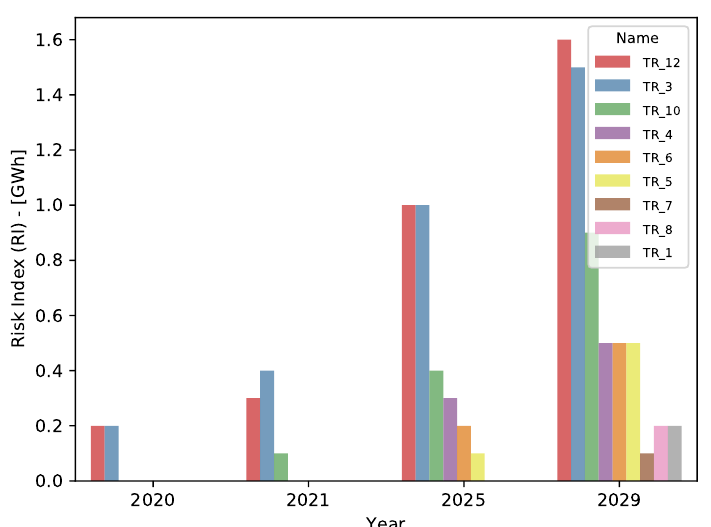
Figure 12. Asset fleet risk index ranking for the assumed periods of